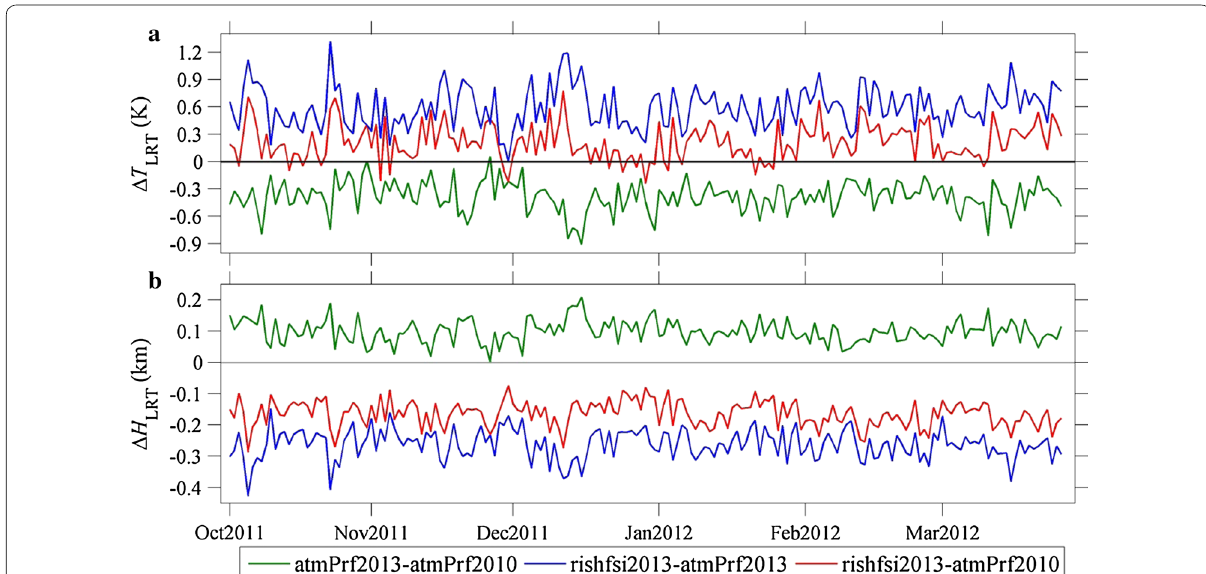
Fig. 6 a Daily mean difference of the LRT temperature (∆ T LRT ) and b the difference of the CPT altitude (∆ H LRT ) among the three COSMIC GPS-RO datasets. Tick marks on the horizontal axis indicate the first day of the corresponding month